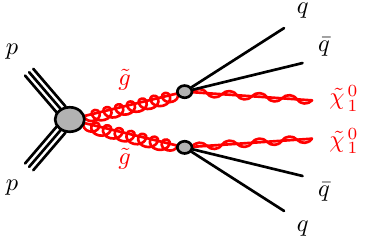
Fig. 3 The schematic diagram of the production process pp → ˜ g ˜ g with the sequent decay ˜ g → q ¯ q ˜ χ 0